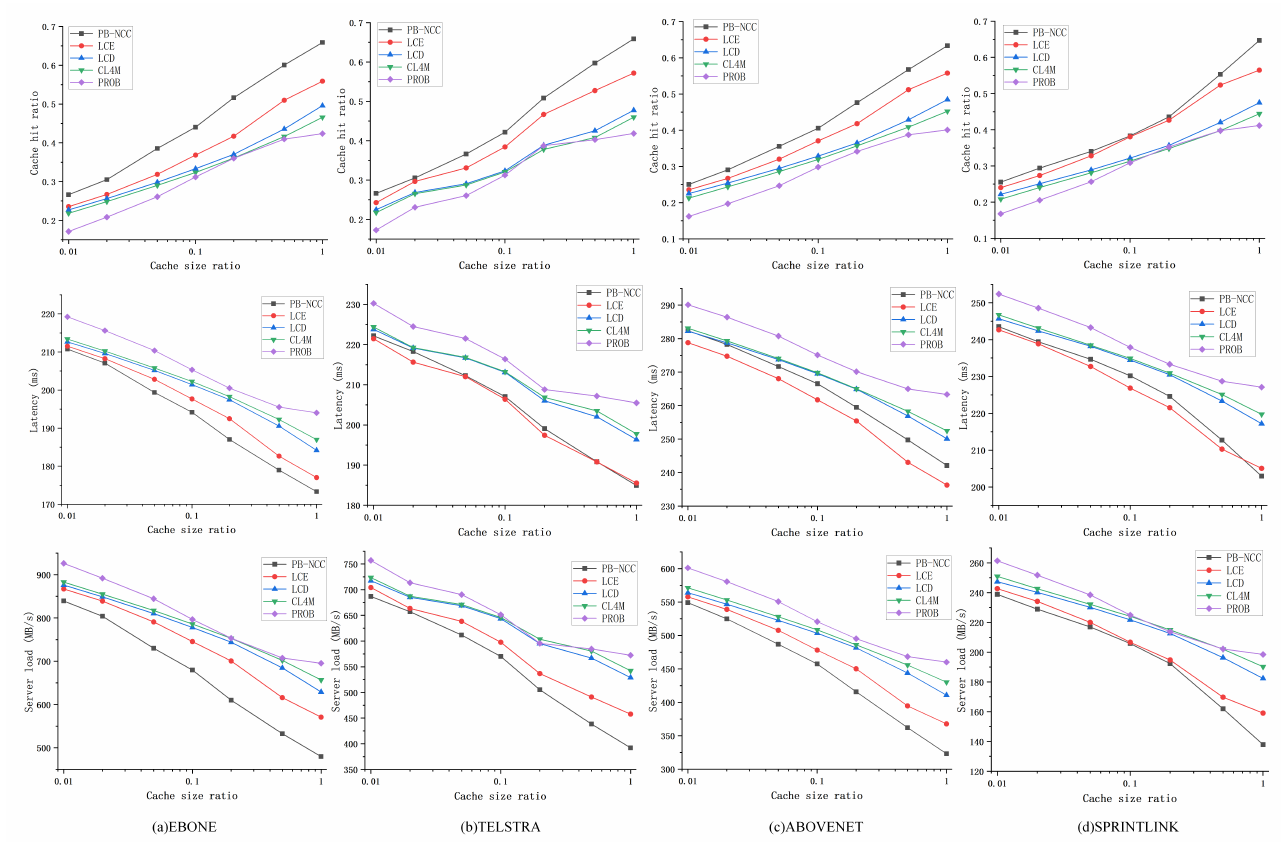
Figure 12. Comparison in ISP-like topologies under YouTube traffic workload. ( a ) performance in EBONE topology under a different cache size ratio; ( b ) performance in TELSTRA topology under a different cache size ratio; ( c ) performance in ABOVENET topology under a different cache size ratio; ( d ) performance in SPRINTLINK topology under a different cache size